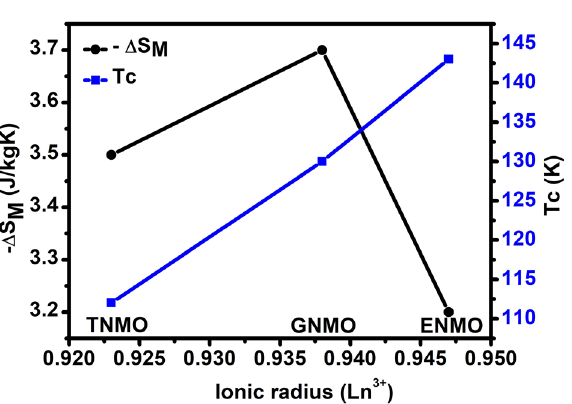
Figure 6. Magnetic entropy changes and Curie temperature of ENMO, GNMO, and TNMO samples with respect to ionic radius. With increasing ionic radius of rare earth element Eu, Gd, and Tb, Curie temperature increases while – ΔS M does show significant